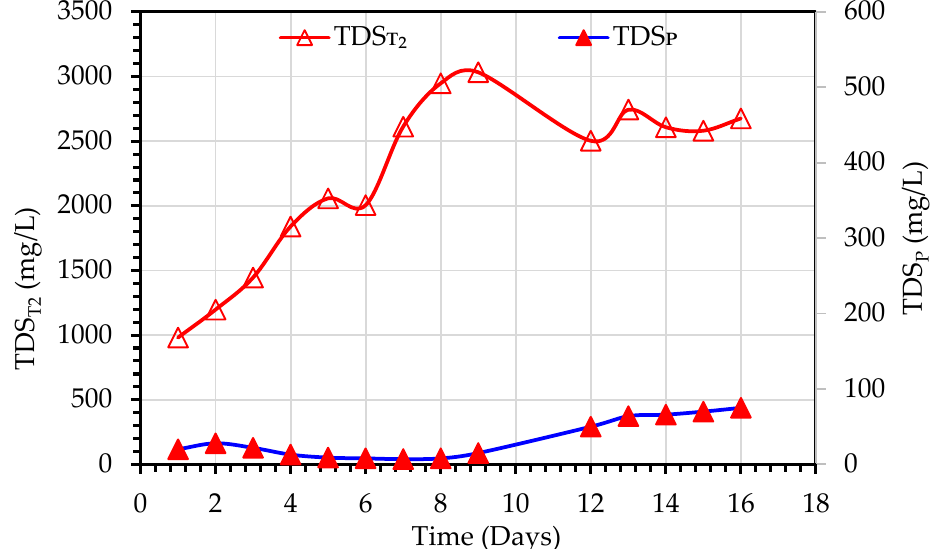
Figure 6. Variations of TDS values observed during the treatment of primary wastewater using a hybrid MBBMR and DCMD system (Experiment 2).